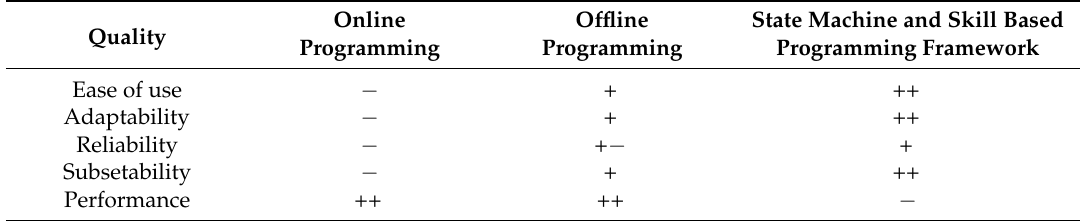
Table 3. Strengths and weakness of different robot programming